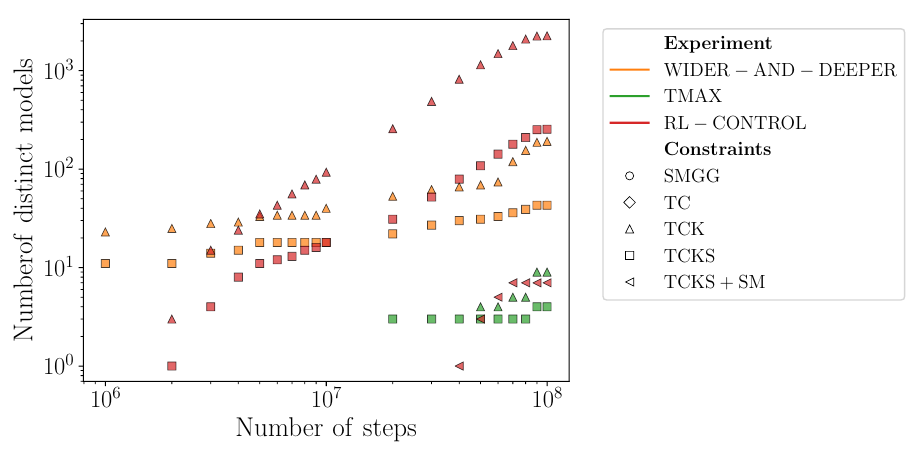
Figure 9 . Number of models of di(cid:11)erent types found for the additional stacking experiments WIDER-AND-DEEPER and